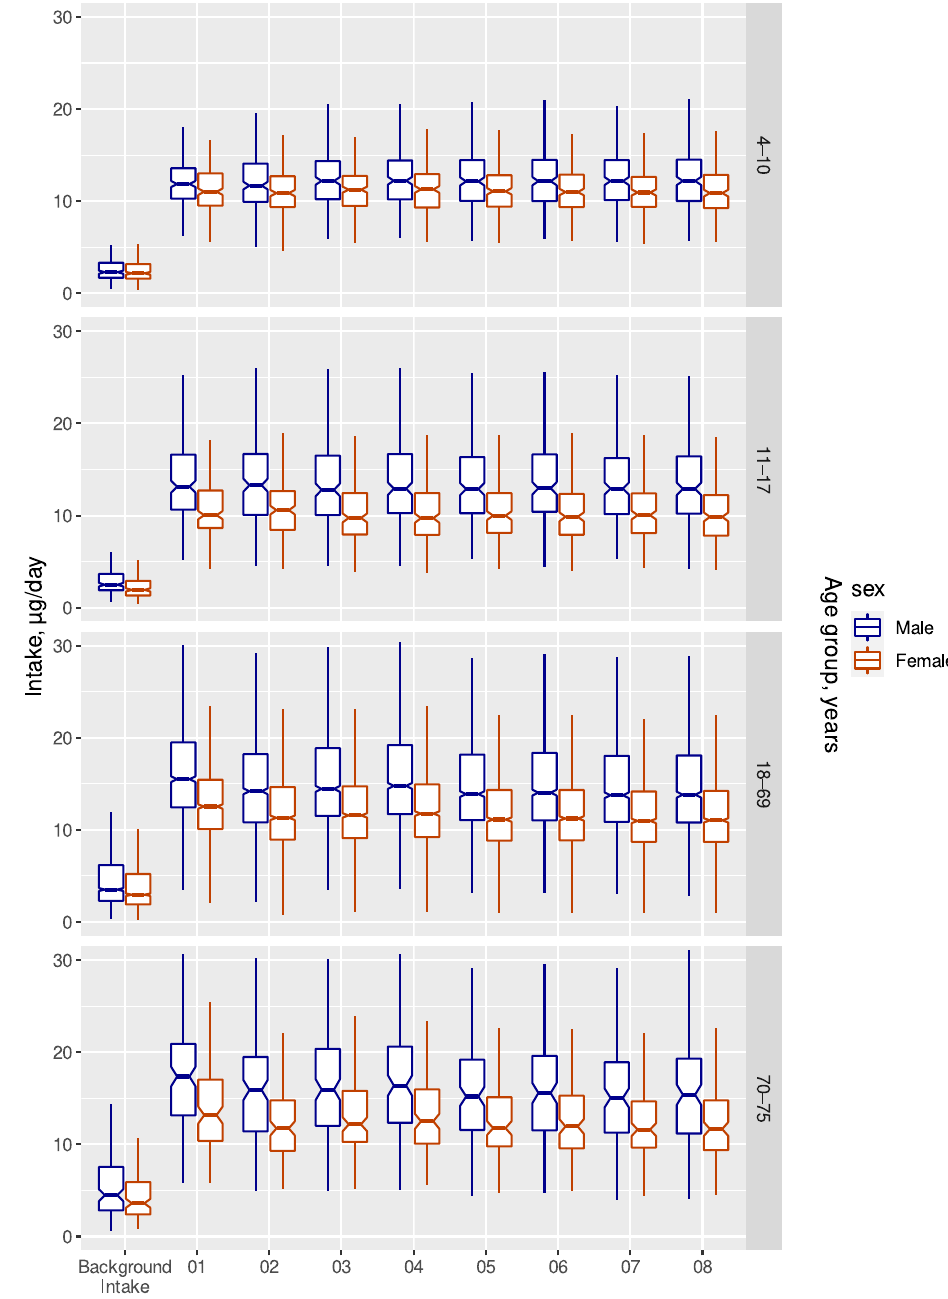
Figure 2. Calculated intake of vitamin D ( µ g/day) for background intake and the eight optimized scenarios by four age groups and sex using individual food intakes from DANSDA. Scenarios are described in Table 1.